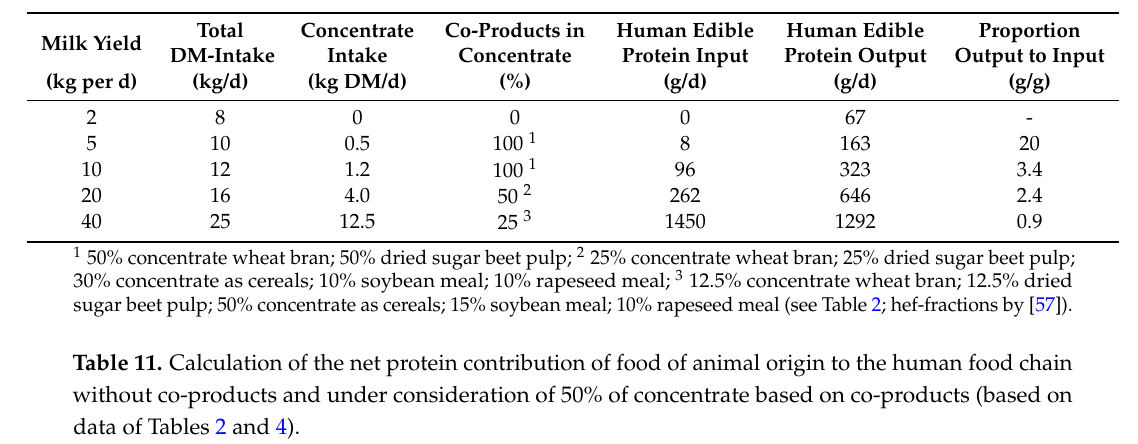
Table 10. Calculation to the net protein contribution of milk production to the human food chain under consideration of various amounts of co-products in concentrate (on the basis of the data in Tables 2 and 4).